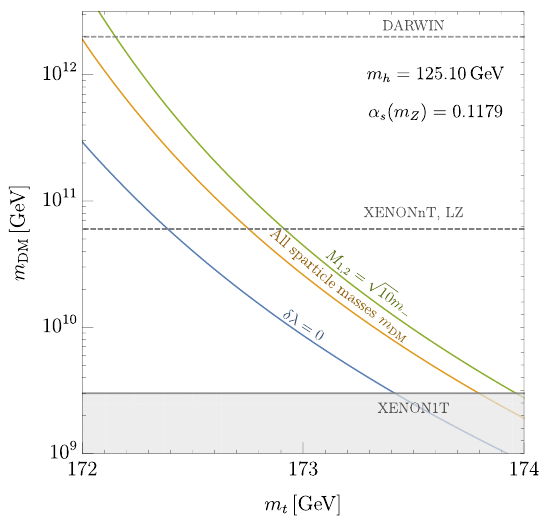
Figure 6 . Upper bound on the dark matter mass m DM as a function of the top quark mass m t for a range of typical threshold corrections. The blue curve shows the bound when the threshold corrections are zero, the orange curve when the sparticle spectra are degenerate m − , and in green , √ 10 m − . Equivalently, the figure shows an upper bound on m t as a function of m DM . when M 1 , 2 =